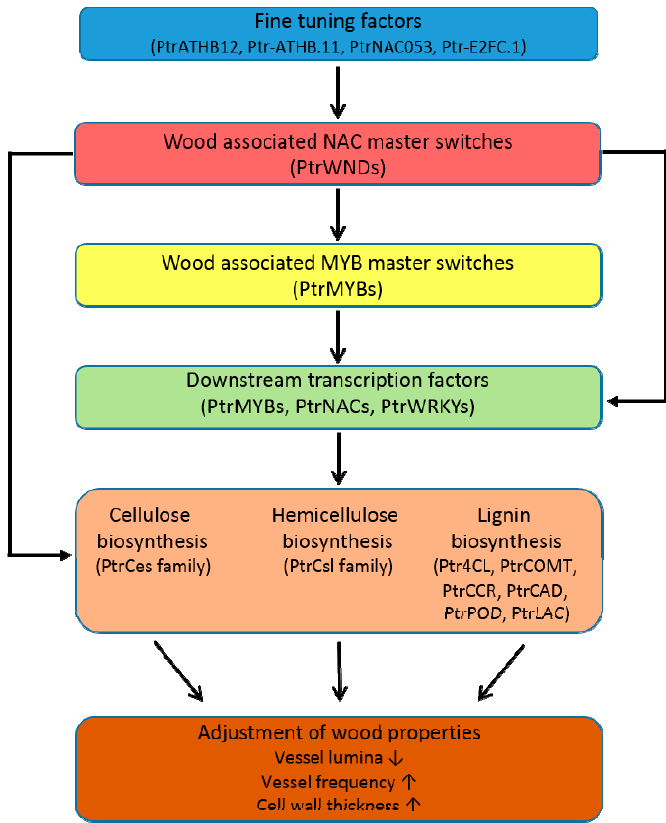
Figure 2. Schematic representation of the molecular mechanisms and gene families leading to xylem formation and acclimation under various stresses. Table 1. List of orthologs of Arabidopsis thaliana wood-formation associated transcription factors present in Populus trichocarpa